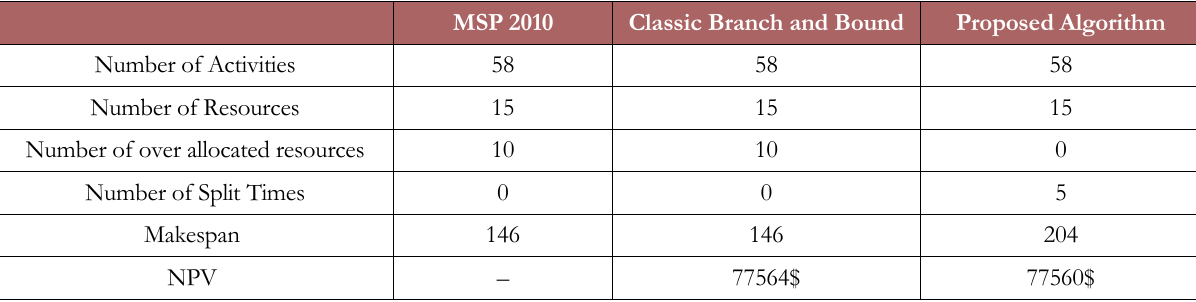
Table 9. Comparing results of scheduling the hospital unig MSP, Classic Branch and Bound and the proposed algorithm